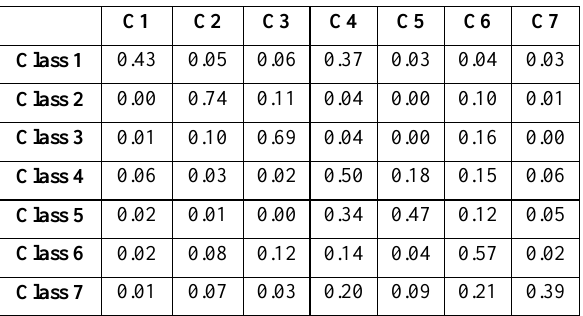
Table 4. Transition probability matrix